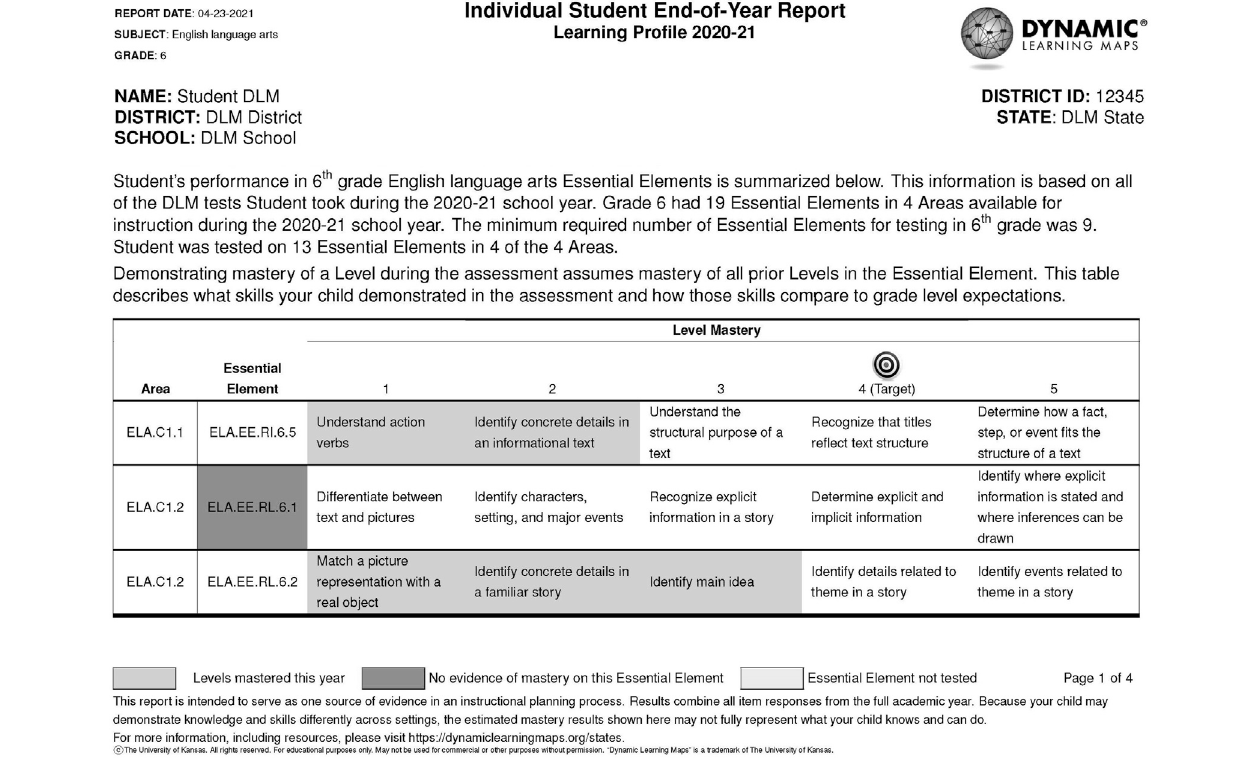
FIGURE 1 | Learning Pro fi le portion of individual student score